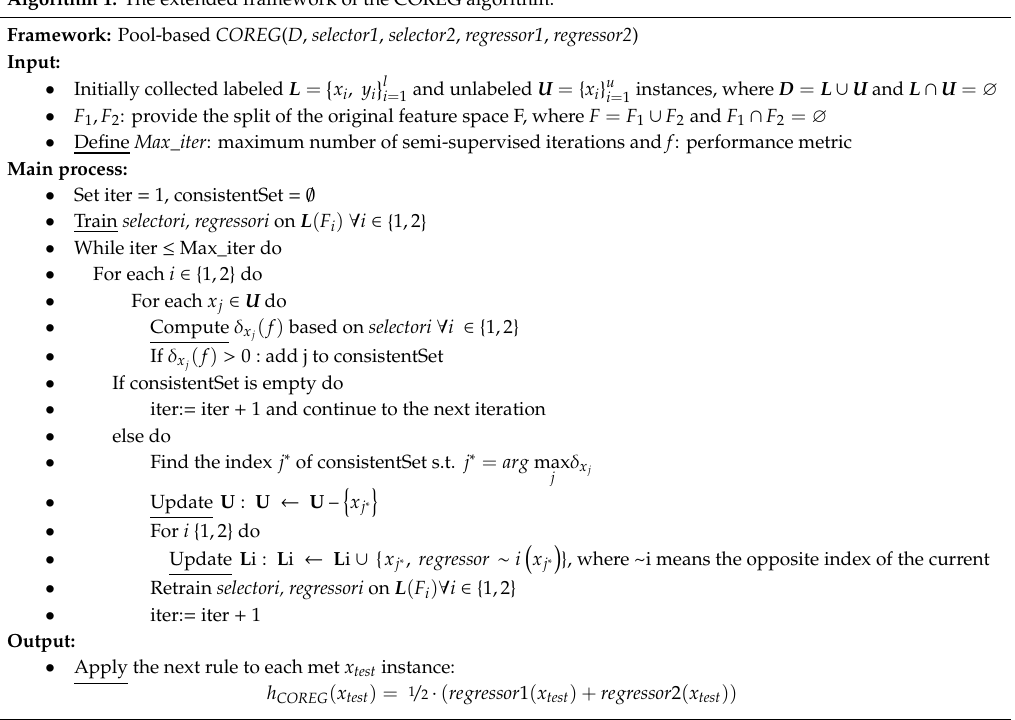
Algorithm 1. The extended framework of the COREG